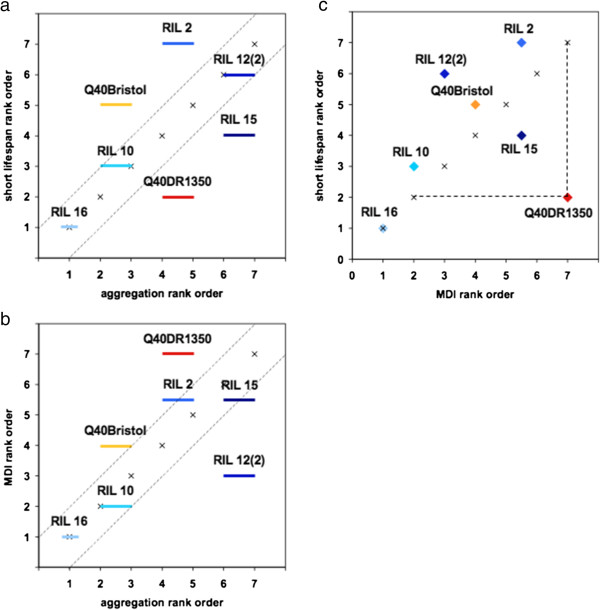
Genetic background determines resistance and tolerance of polyQ aggregation. (a,b) Relative ranking of indicated polyQ-carrying strains in aggregation and two toxicity correlates: (a) abnormally short lifespan and (b) muscle dysfunction. Aggregation ranking is as described in supplementary materials (see Additional file 2: Figure S2b). Strains that are paired share aggregation rank, and RIL 16 is unpaired. Placement above or below the diagonal indicates decreased or increased tolerance, respectively. (c) Variation in polyQ aggregation tolerance measured by shortening of lifespan could be separated from that measured by muscle dysfunction. DR1350 is indicated as an example of decreased tolerance in terms of muscle dysfunction relative to lifespan.